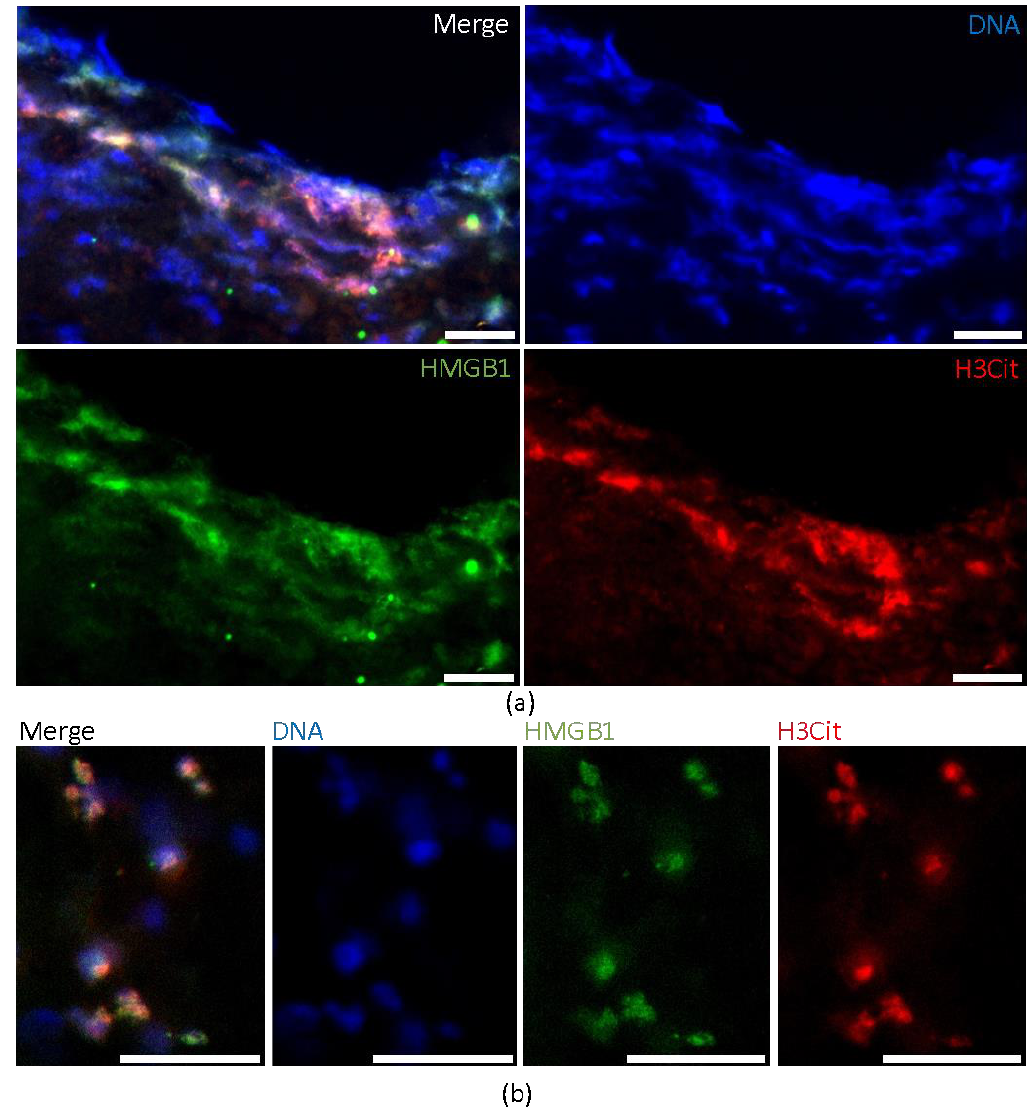
Figure 3. Immunofluorescent coexistence of HMGB1 and NETs. Immunofluorescent co-staining identifies large areas with colocalization of ( a ) DNA (by DAPI), HMGB1 and H3Cit demonstrating the existence of HMGB1 in NETs. Representative magnifications illustrate small punctual coexistence ( b ) of HMGB1 and H3Cit revealing NETosing neutrophils. Scale bars: ( a , b ) 20 µm. HMGB1 = high mobility group box 1, DAPI = 4,6-diamidino-2-phenylindole.